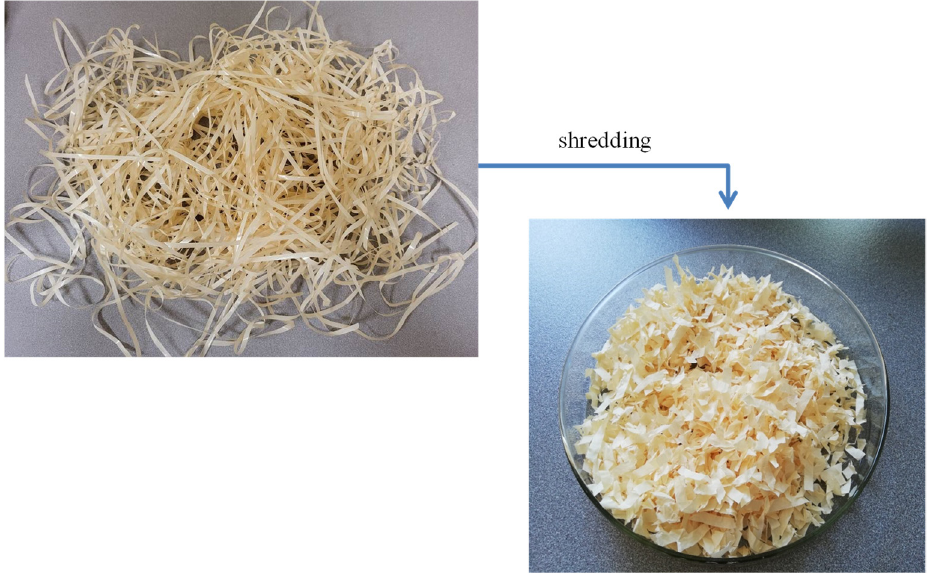
Figure 1. Initial and final form of the filler.